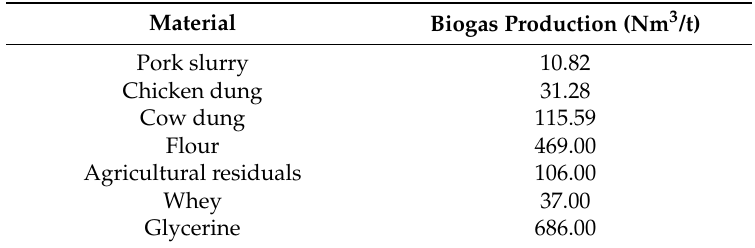
Table 3. Unit production of biogas for each type of material (data from [21]).